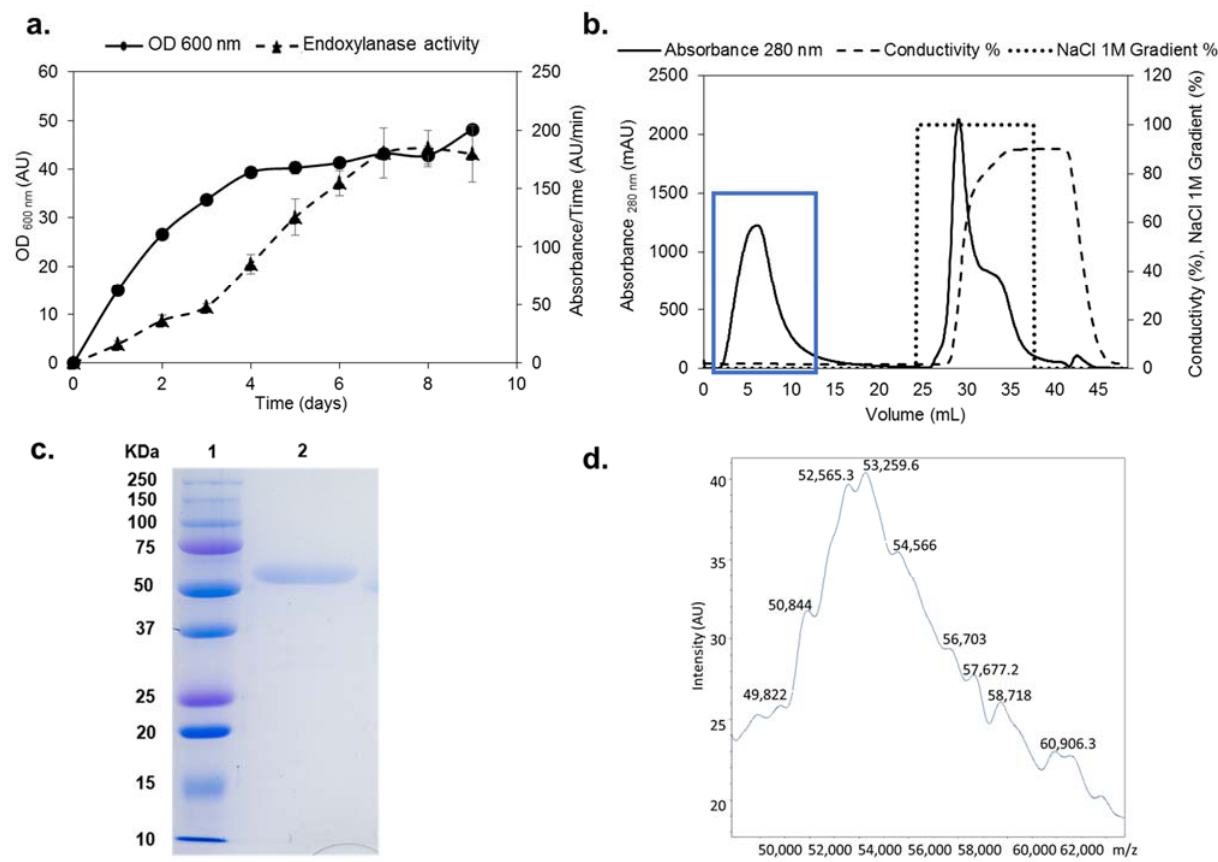
Figure 1. Production, purification, and characterization of rXynSOS. ( a ) Endoxylanase activity against AZCL–beechwood xylan and OD 600 nm of the selected rXynSOS P. pastoris clone grown for 9 days in YEPS medium with methanol induction. ( b ) Purification of rXynSOS from P. pastoris crude extracts by anion-exchange chromatography. Protein absorbance through the NaCl gradient was monitored. The enzyme was purified in one single step. The blue rectangle indicates the peak of enzyme elution. ( c ) Determination of rXynSOS estimated molecular mass (Mw) by SDS-PAGE with the molecular weight marker displayed in lane 1. ( d ) MALDI-TOF spectrum of rXynSOS showing the profile of a glycosylated protein.